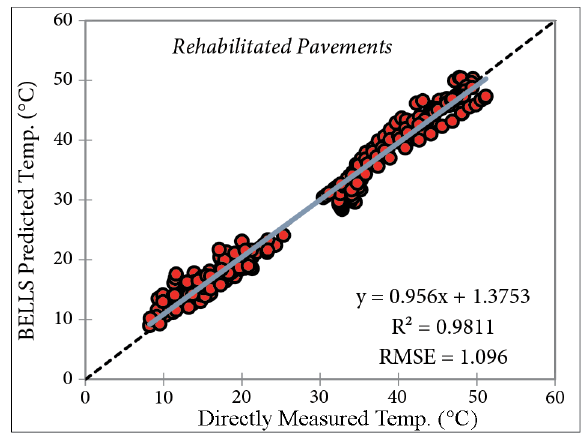
Figure 9. BELLS predicted versus directly measured temperatures in rehabilitated